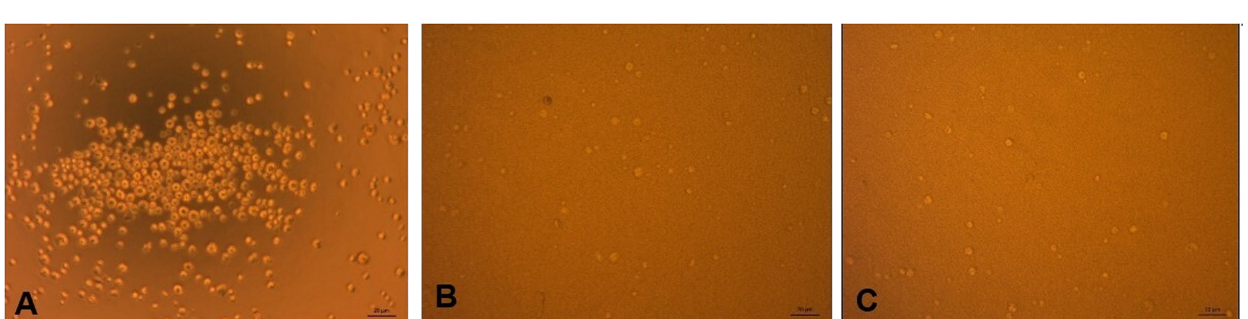
Figure 2. ( A ) SHSY-5Y cell before exposure to P. gingivalis , ( B ) After exposure to P. gingivalis without antibodies, ( C ) After exposure to P. gingivalis with antibodies. (Light microscope, 20x